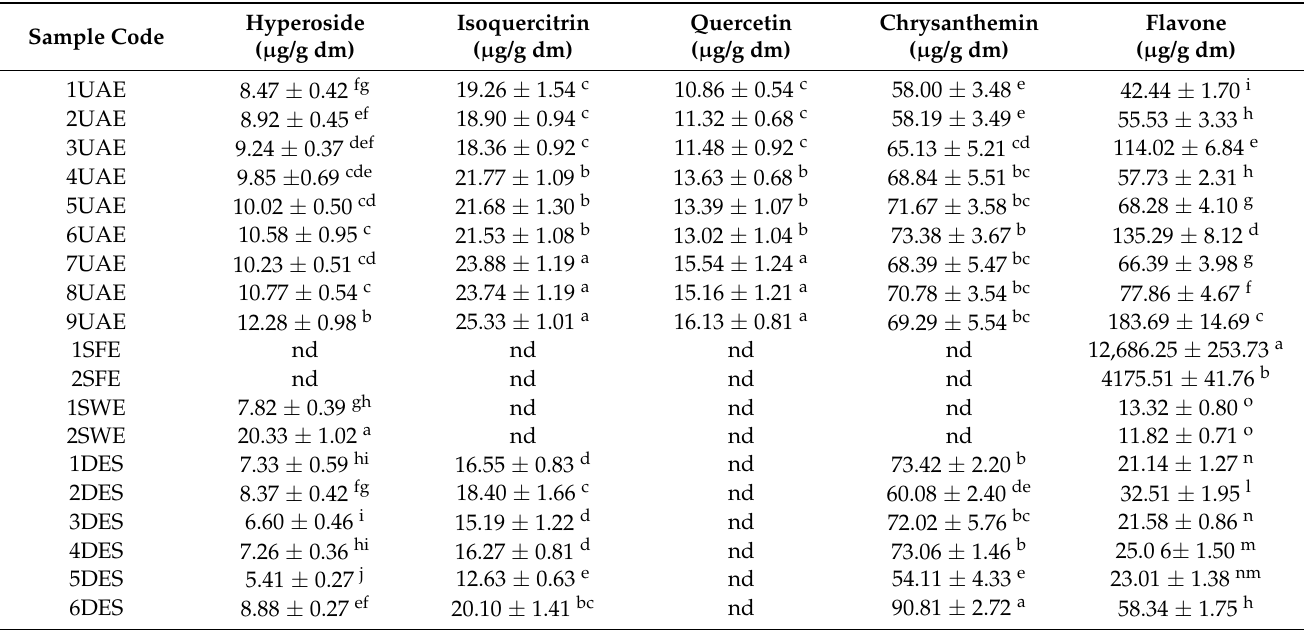
Table 2. Concentrations of targeted flavonoids obtained from feijoa flowers extracted with different green extraction